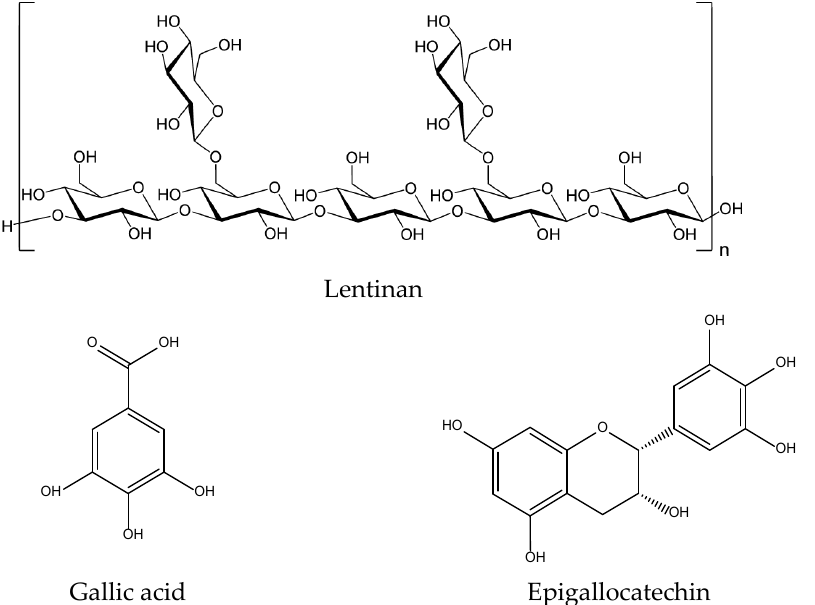
Figure 11. Bioactive anti-inflammatory (eicosanoid inhibition) and antioxidant principles from Lentinus edodes .